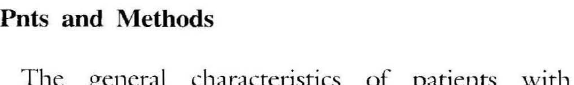
Table 1. Characteristic of patients with autoimmune rheumatic diseases S\"stemic lupus erythematosus Rhcumatoid arthritis l't>l\'myositis/dermatomyositis \ \'t"gt"ner's